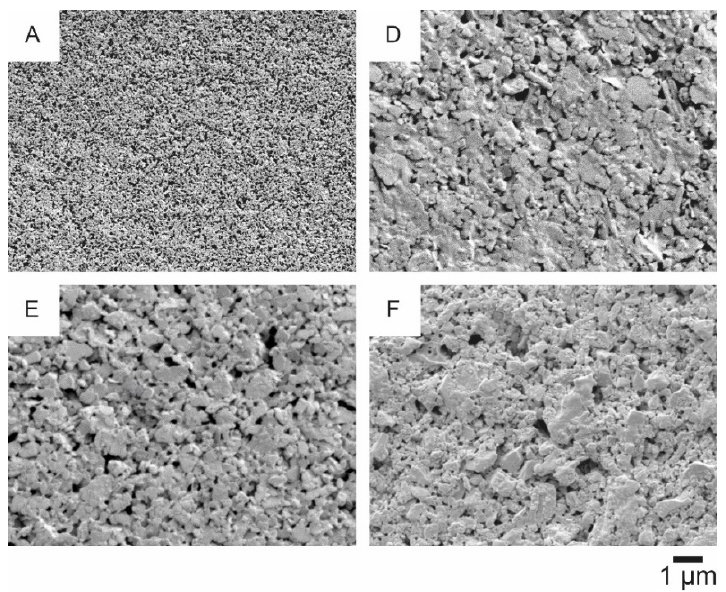
Figure 11. SEM images at a magnification factor of 10,000 of the following substrates: p_e:smart paper type 2 ( A ), Koehler Type E ( D ), Algro Baress ( E ), Magno Satin ( F ).